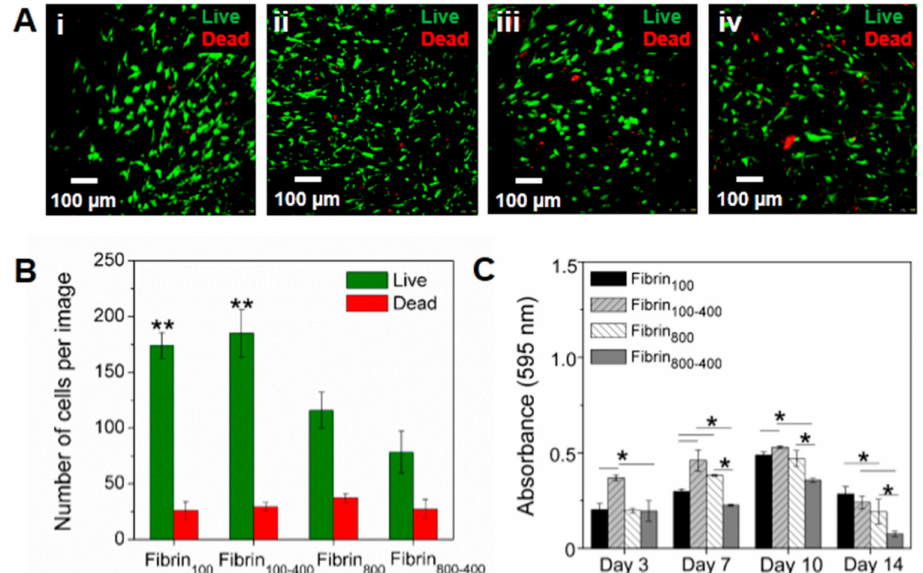
Figure 6. Assessment of h-AdMSC behavior seeded in the four types of fibrin nanofibers. ( A ) Cell viability on the seventh day of incubation in (i) fibrin 100 , (ii) fibrin 100-400 , (iii) fibrin 800 , and (iv) fibrin 800-400 . ( B ) Number of living and dead h-AdMSCs in the nanofibers incubated for seven days and calculated from three di ff erent images using ImageJ software. Note: ** Significantly di ff erent from fibrin 800 and fibrin 800-400 ( p < 0.05). ( C ) Proliferation kinetics for h-AdMSCs seeded in the fibrin networks of the L-PRP preparations. Note: * p <